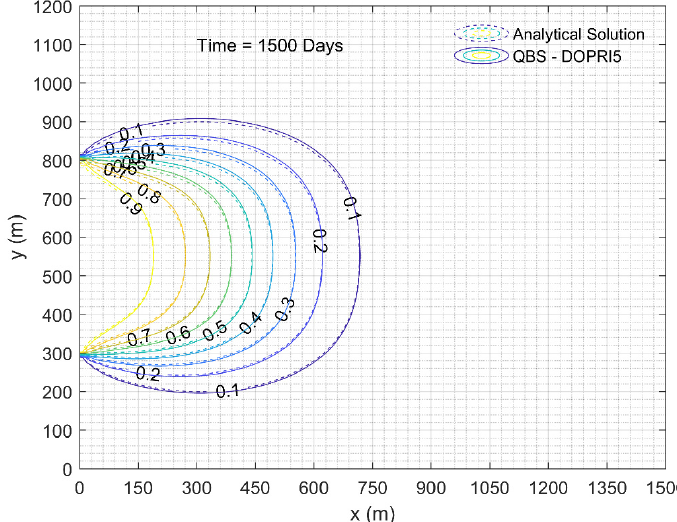
Figure 3. Comparison of approximate solution obtained with QBS-DOPRI5 and analytical solution at time = 1500 days ( ∆ x = 20 m, ∆ y = 16 m )